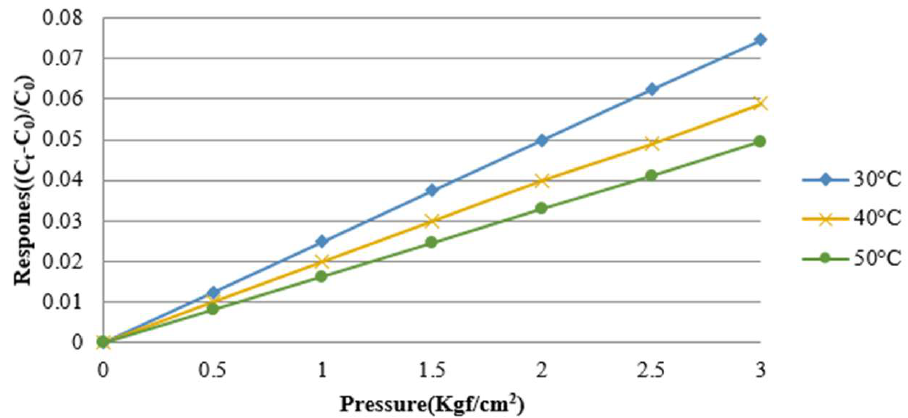
Figure 4 . Correction curve of the micro pressure sensor.